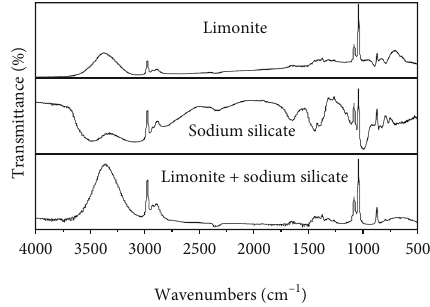
Figure 13: FTIR spectra of limonite and sodium hexametaphosphate.